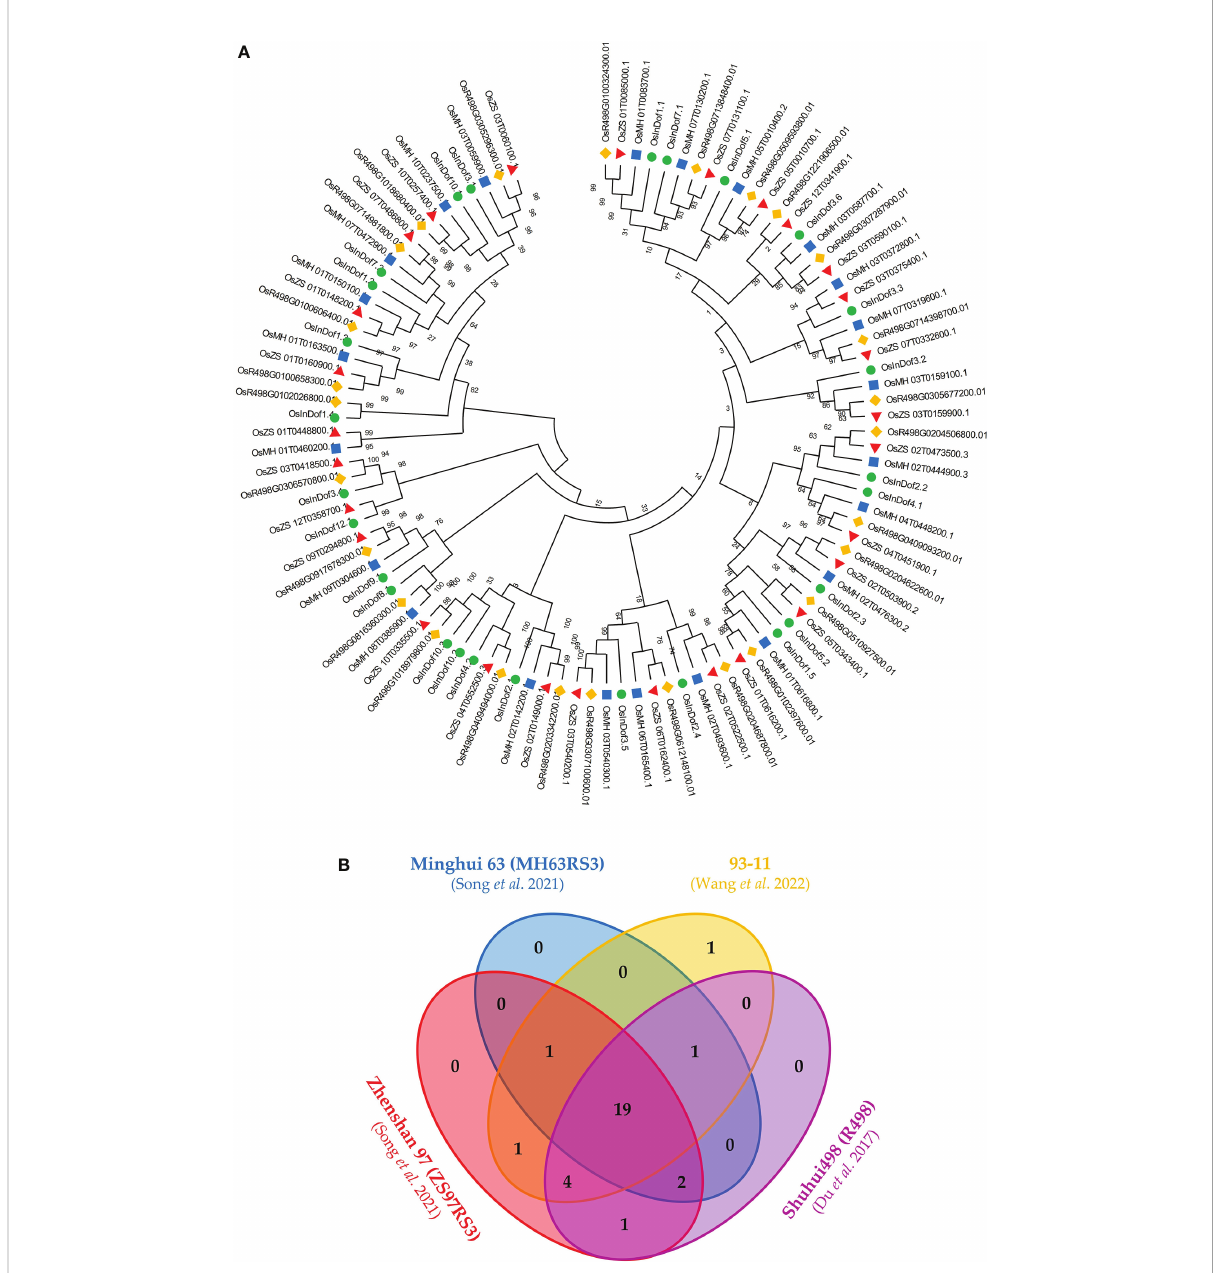
FIGURE 1 Comparison of Dof proteins among four elite genotypes (93-11, MH63, ZS97, and R498) of O. sativa indica . (A) The comparative phylogenetic tree of Dofs from four elite genotypes of indica rice. The evolutionary history was inferred using the Neighbor-Joining method (Saitou and Nei, 1987). The evolutionary distances were computed using the Poisson correction method (Zuckerkandl and Pauling, 1965) and are in the units of the number of amino acid substitutions per site. This analysis involved 105 protein sequences. All positions containing gaps and missing data were eliminated (complete deletion option). There was a total of 51 positions in the fi nal dataset. Evolutionary analyses were conducted in MEGA X (Kumar et al., 2018). (B) Comparison of presence of Dof protein among four indica rice elite genotypes through Venn